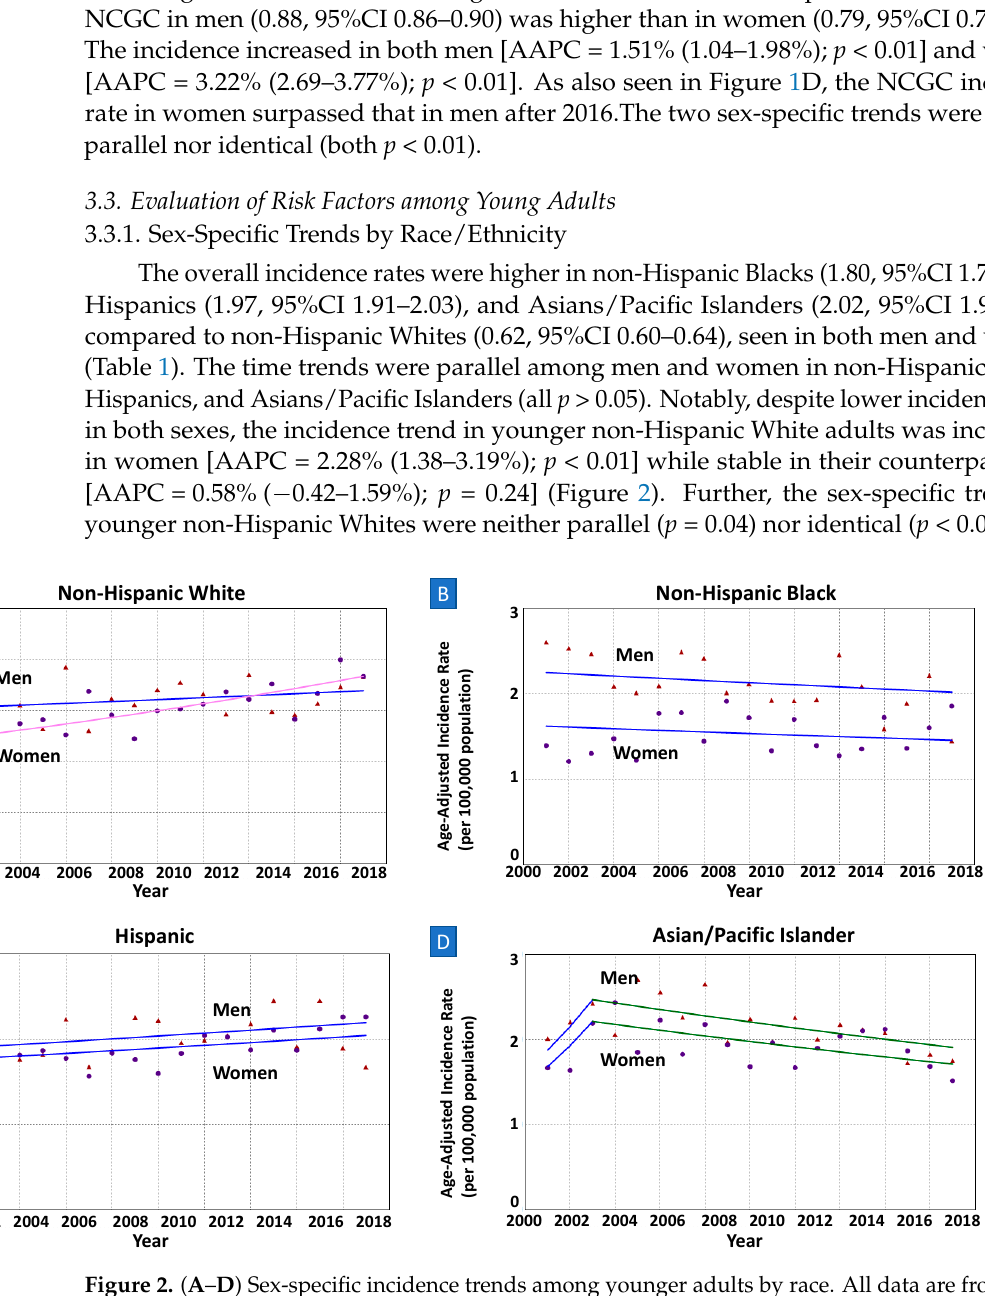
Figure 2. ( A – D ) Sex-specific incidence trends among younger adults by race. All data are from SEER database, among those of age < 55 years. Lines of both men and women are same colors if trends are parallel, meaning same APC and AAPC values during the interval years. ( A ) In Non-Hispanic Whites, APC in women is increasing at a greater rate than in men with non-parallel trends (AAPC 2.28% vs. 0.58%; p -value < 0.04). ( B – D ) In Non-Hispnanic Blacks, Hispanics, and Asian/Pacific Islanders, incidence trends in women and men were identical but not parallel ( p -values 0.06, 0.17, 0.32,